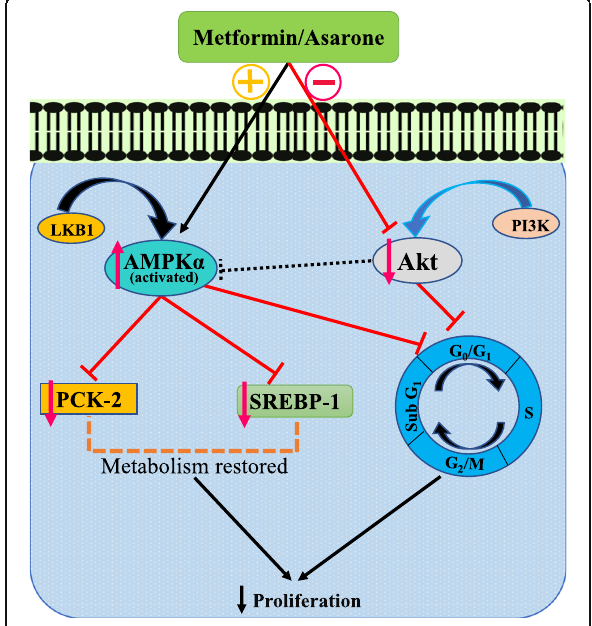
Fig. 8 Schematic representation of the mechanism by which metformin and asarone cause G 0 /G 1 arrest by regulation of AMPK via PCK-2 and SREBP-1 as well as Akt signaling pathway in a high glucose environment in HepG2